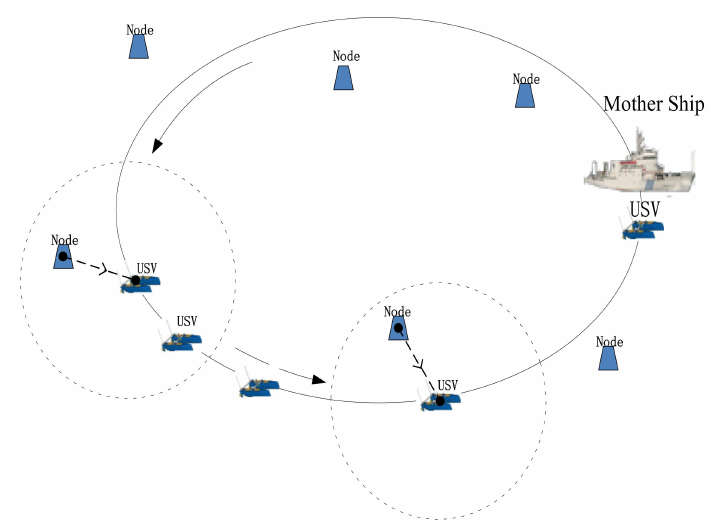
Figure 1. Sparse network data collection